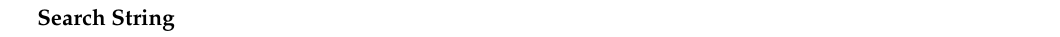
Table A1. Search strategy string.